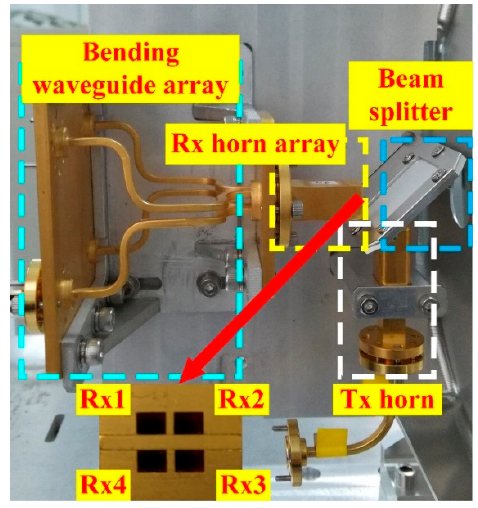
Figure 2. Prototype of the SIMO antenna array.